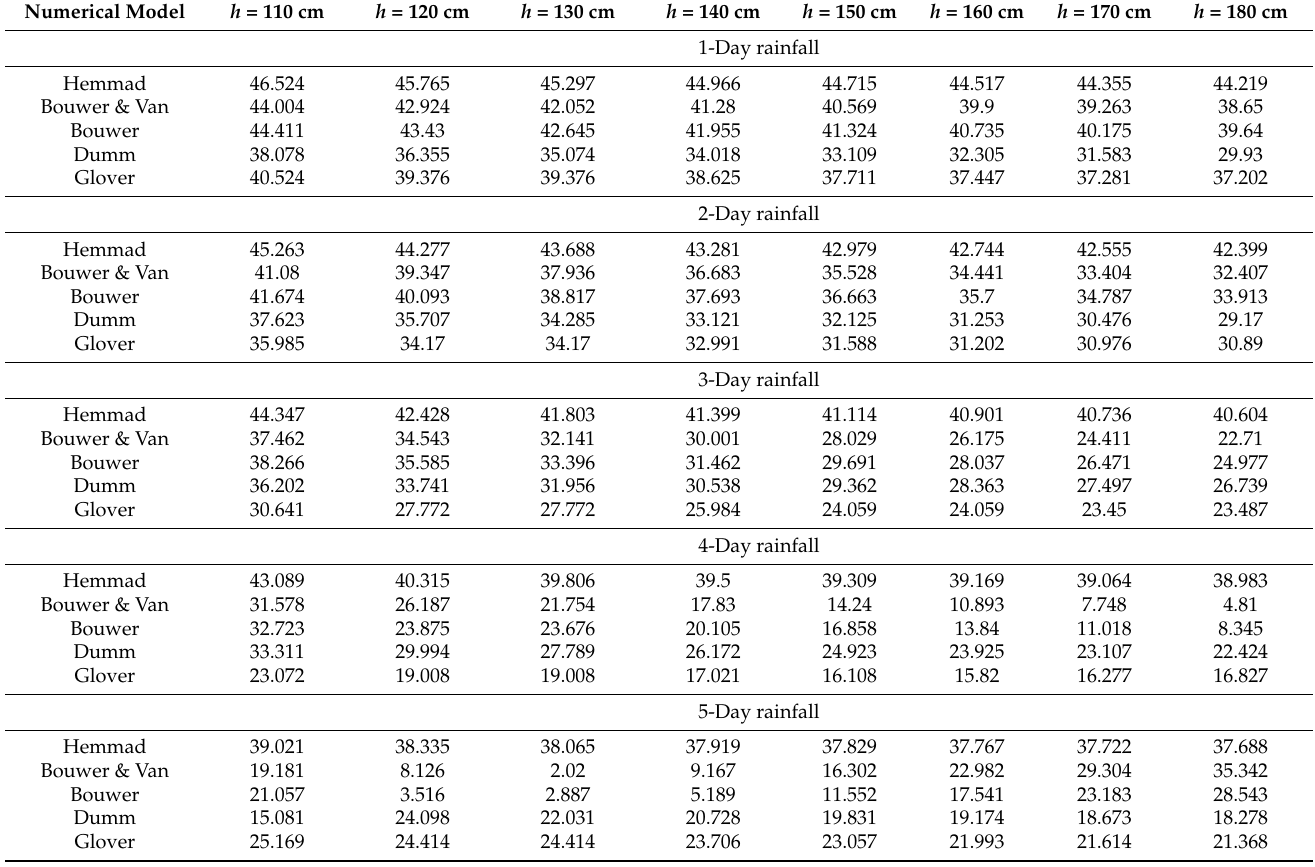
Table 6. Numerical values of (RMSE) under daily rainfall for 1 to 5 days in the depth of drainage at the rate of 110 cm; 180 cm above the ground.